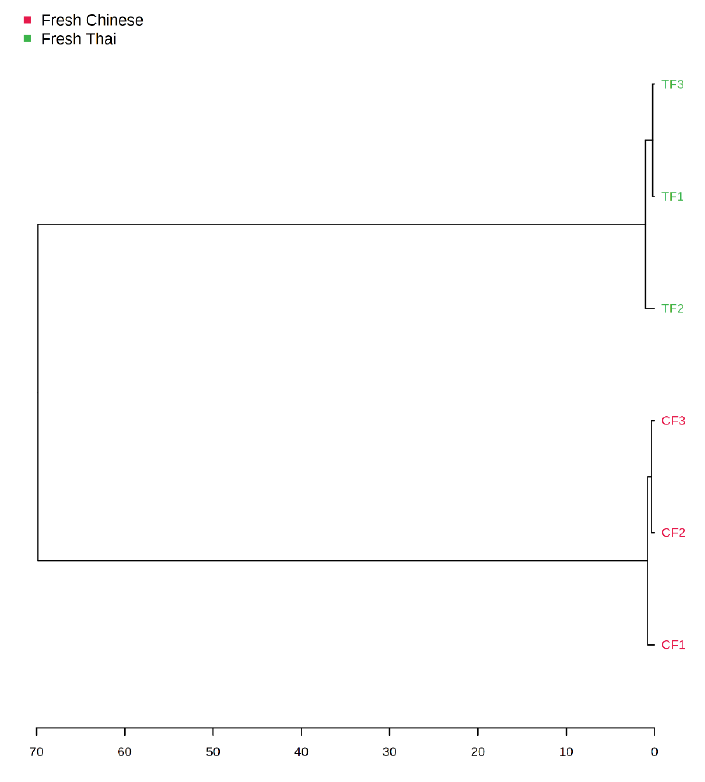
Figure 3. Cluster analysis of ginger varieties, i.e., Chinese and Thailand. Heat maps were generated to determine the significantly varying compounds of each variety. In the heat map, two clusters in rows and columns were generated and high- lighted by the hierarchical clustering; different clusters of samples indicate significant dif- ferences in two ginger varieties, i.e., Chinese and Thailand. The color difference showed the abundance of different volatile compounds extracted from ginger varieties (Figure 4). The results show that many compounds abundant in the Chinese cultivar shown in red color are rare in the Thailand cultivar, while compounds abundant in the Thailand